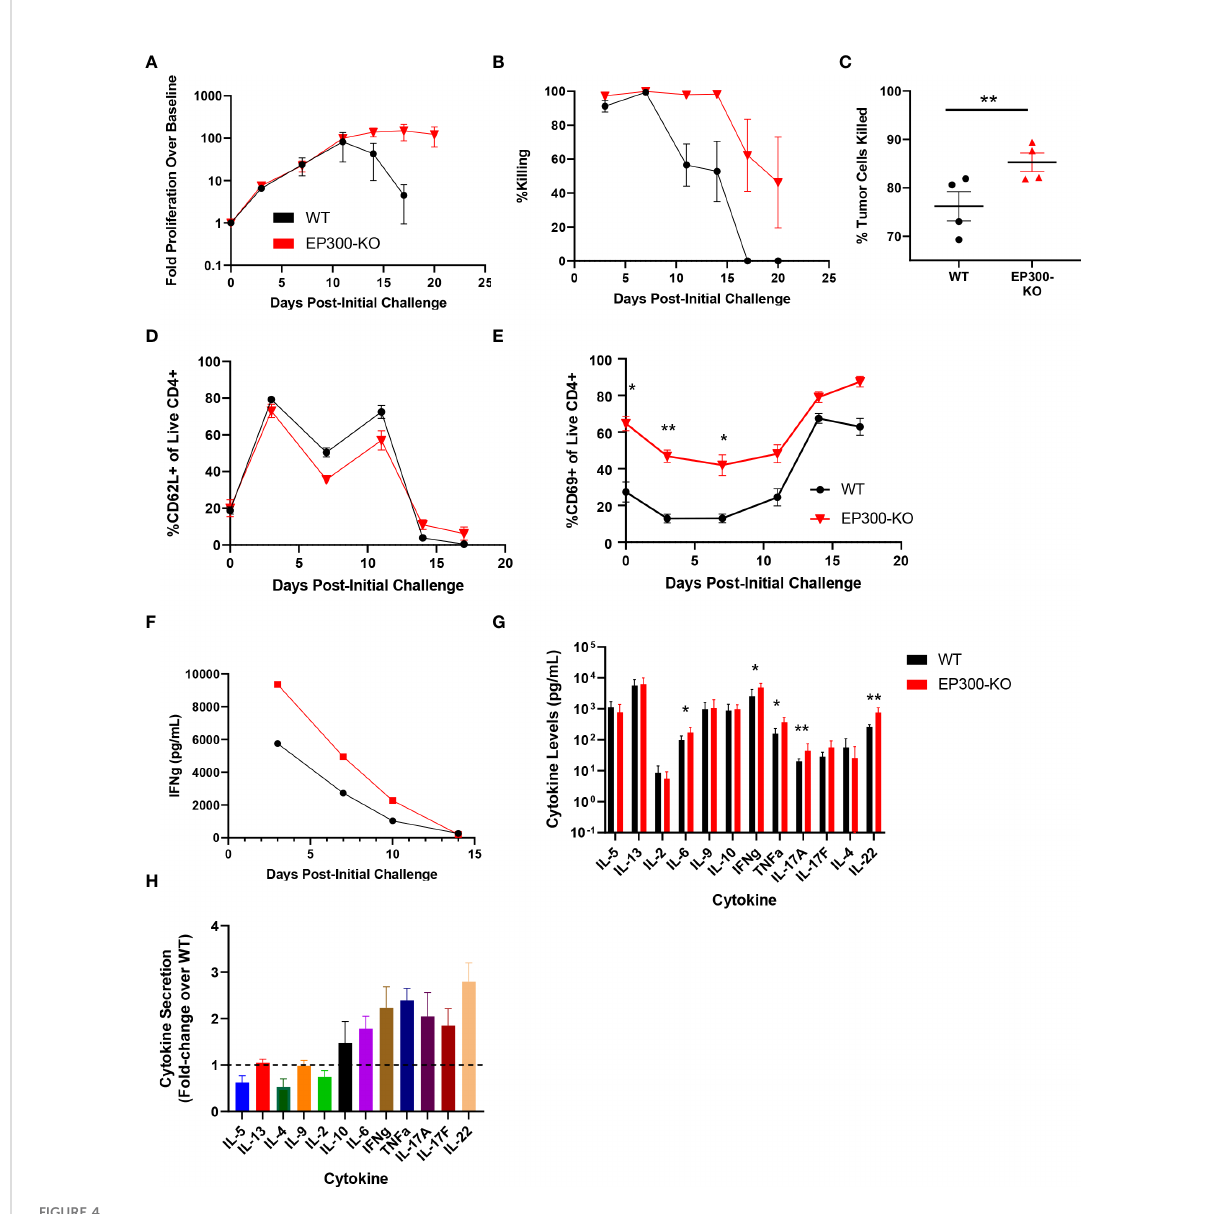
FIGURE 4 EP300 encodes a negative regulator of BsAb-mediated T cell activation and cytotoxicity. EP300-KO CD4+ T cells and WT CD4+ T cells were used in a long-term repeat challenge assay. (A) T cell proliferation over time was monitored by fl ow cytometry. (B) KMS11 target cell killing by the indicated T cell populations was monitored over time by fl ow cytometry. (C) Target cell killing was measured based on luciferase activity during Challenge 2 after 24 h, revealing more complete target cell killing by EP300- KO CD4+ T cells at this time point. (D) The frequency of CD62L+ CD4+ T cells in the indicated groups was monitored over time by fl ow cytometry. (E) The frequency of CD69+ CD4+ T cells in the indicated groups was monitored over time by fl ow cytometry. (F) Supernatant IFN g levels were measured over time by ELISA in the indicated treatment cells. (G) A LegendPlex cytokine assay was used to quantify the levels of the indicated cytokines in supernatants collected from WT or EP300-KO CD4+ T cells at the end of Challenge 1. (H) Cytokine levels in EP300- KO CD4+ T cell samples in (G) were normalized to levels in WT cell samples. All validation data in (A-E) and (G-H) were generated using T cells from four separate donors, and are representative of two experiments. Data in (F) are derived from a single donor and are representative of two experiments. *P<0.05, **P<0.01; Data were analyzed using two-way ANOVAs or Paired Student ’ s t-test with multiple testing correction as appropriate. Data are presented as the mean with standard error of the